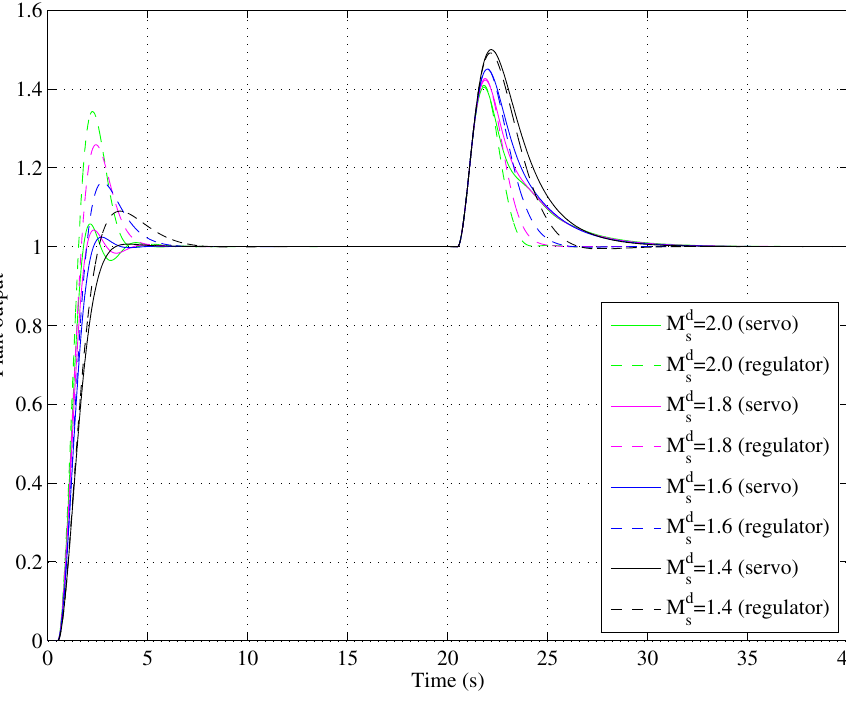
Figure 11. Servo and regulation performances for a =